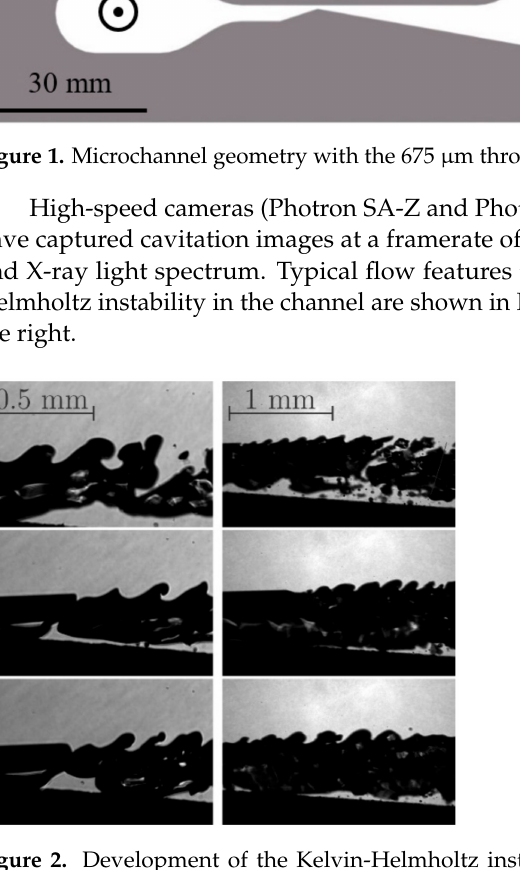
Figure 2. Development of the Kelvin-Helmholtz instability in the microchannel ( ∆ p = 4.00 bar, σ =